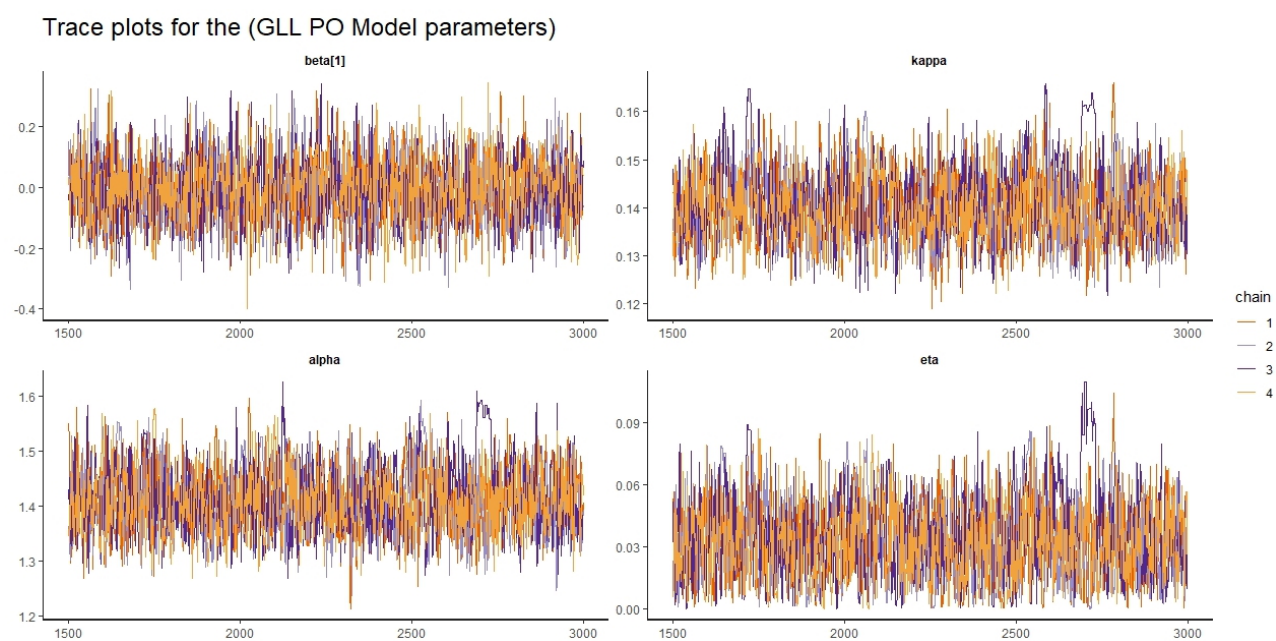
Figure 11. Trace plots for the GLL − PO model